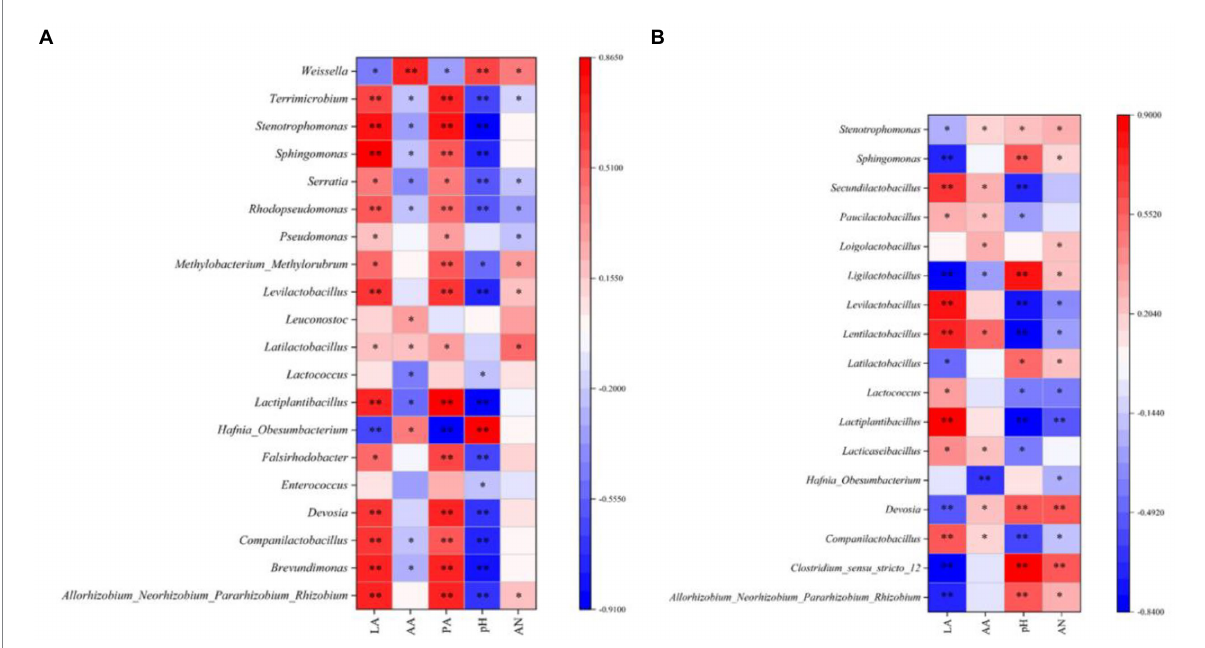
FIGURE 2 Spearman correlations between the silage fermentation parameters and the top 20 genera at 7 days (A) and 45 days (B) . LA, lactic acid; AA, acetic acid; PA, propionic acid; AN, ammonia nitrogen; p values are shown as * 0.01 < p ≤ 0.05, ** 0.001 < p ≤ 0.01; 100% MS, 100% alfalfa; 70% MS + 30% LP, 70% alfalfa+30% perennial ryegrass; 50% MS + 50% LP, 50% alfalfa+50% perennial ryegrass; 30% MS + 70% LP, 30% alfalfa+70% perennial ryegrass; 100% LP, 100% perennial